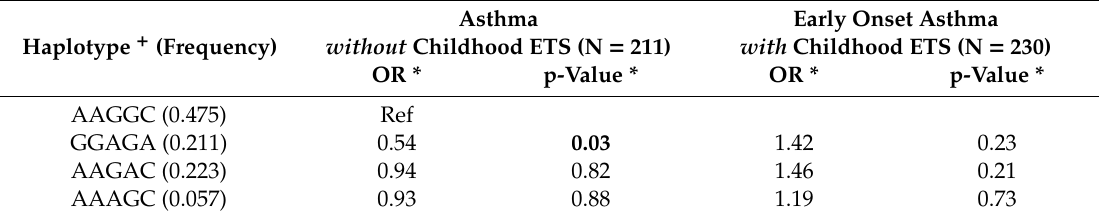
Table 6. Haplotype association for asthma and early onset asthma stratified by childhood ETS. Asthma Early Onset Haplotype + (Frequency)